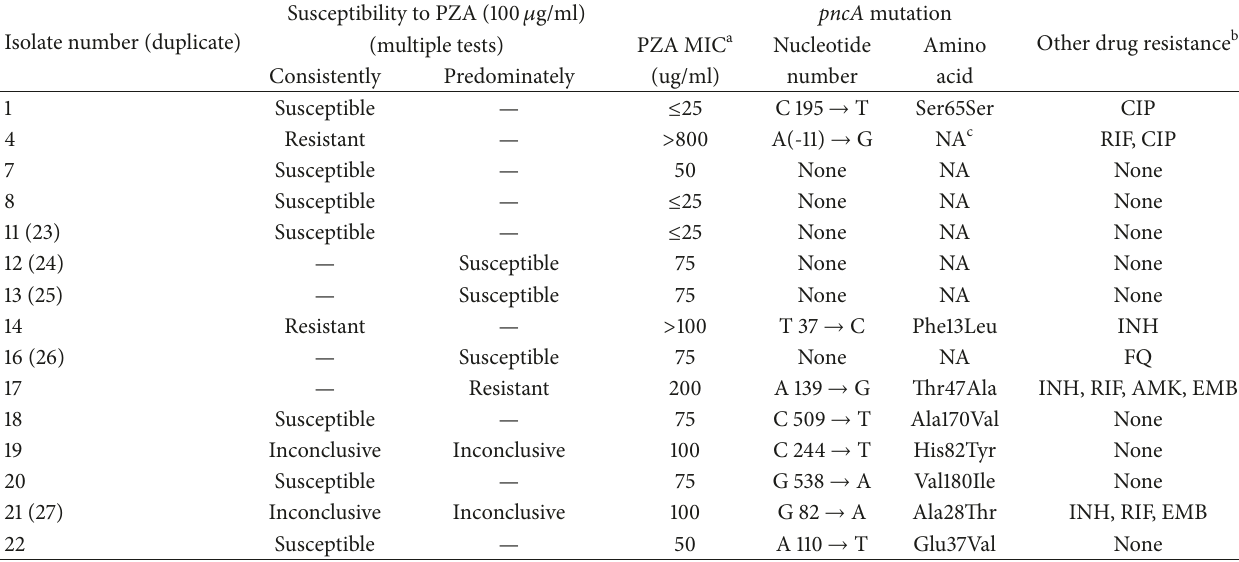
Table 1: Characteristics of 20 M. tuberculosis strains used in the multicenter evaluation.